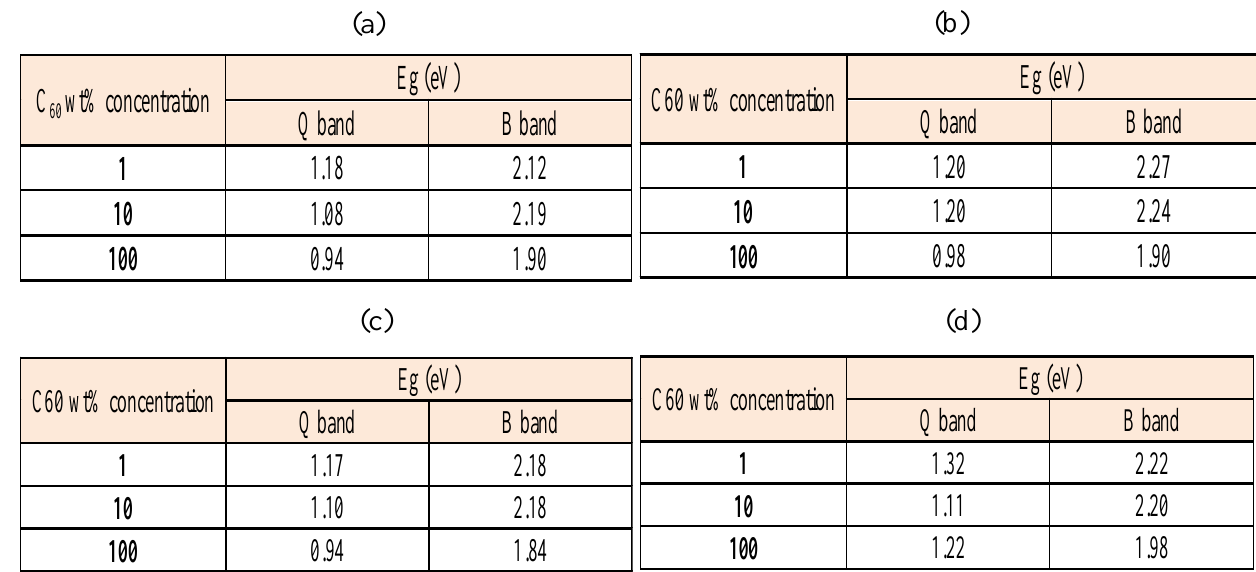
Table 2: Variation of optical energy gaps of (NiPc/C ratios (a) R.T, (b) Ta=373 K, (c) 423 K and (d) 473 K